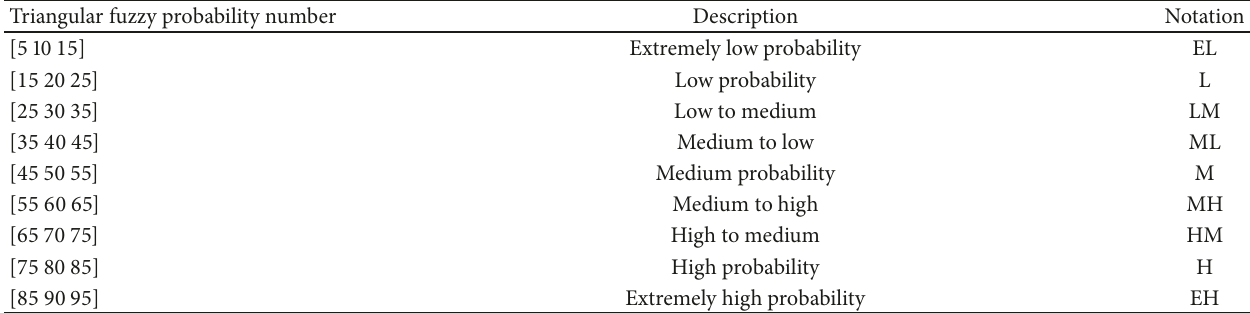
Table 2: Fuzzy probabilities.